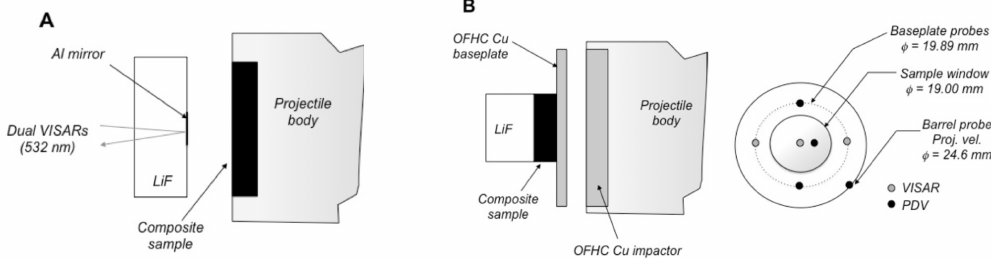
Figure 7. ( A ) Front surface impact geometry. Samples (in this case, a composite) were mounted to the front of a Lexan projectile, then launched into an oriented [100] single-crystal LiF window using a two-stage light gas gun. The interface particle velocity was measured using dual-velocity-per-fringe VISARs and the Doppler shift of light from a diffuse 8 kÅ Al reflector at the impact interface. ( B ) Schematic of the “top-hat” target configuration used for making shockwave transmission measurements in high-pressure plate impact experiments driven by a two-stage powder gun. Shockwave transit times are determined from the difference in shock arrival at the rear surface (sample side) of the baseplate and the sample/window (LiF) interface, as determined using multiple VISAR and PDV probes corrected for system timing and impactor tilt. Probe placements are shown at right, based on a rear-view of the target. An 8 kÅ Al reflector was coated onto the LiF window at the LiF/sample interface for the VISAR and PDV velocimetry